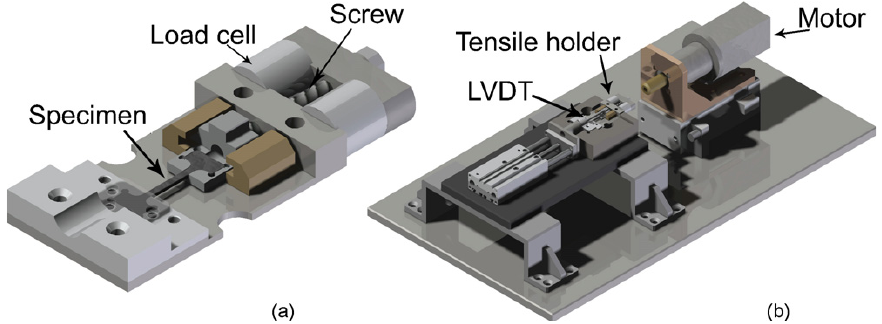
Figure 4: Tensile holder with microtensile specimen (a); fatigue testing machine